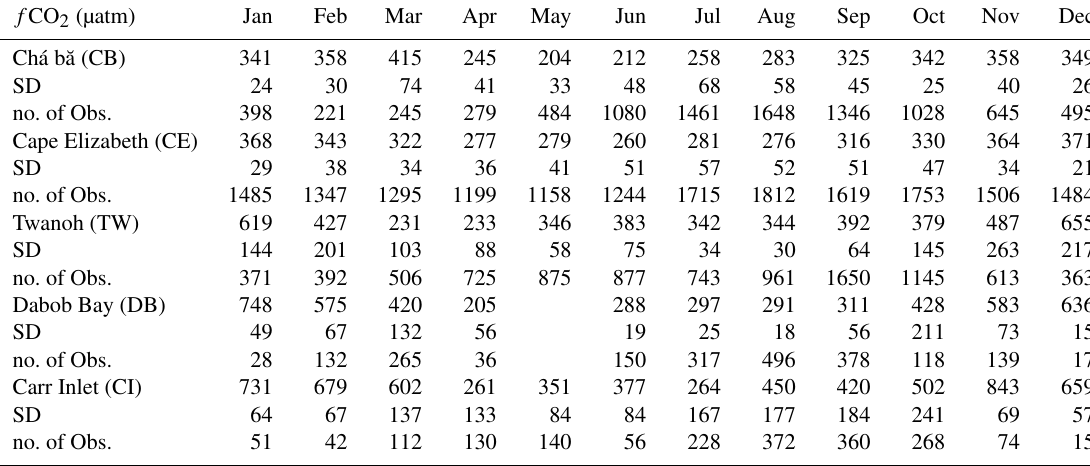
Table C5. Average monthly f CO 2 seasonal cycles for the five Washington State moorings with CO 2 sensors or sufficient observations to estimate f CO 2 . The average monthly standard deviation (SD) and total number of observations (no. of Obs.) contributing to the monthly average estimate are